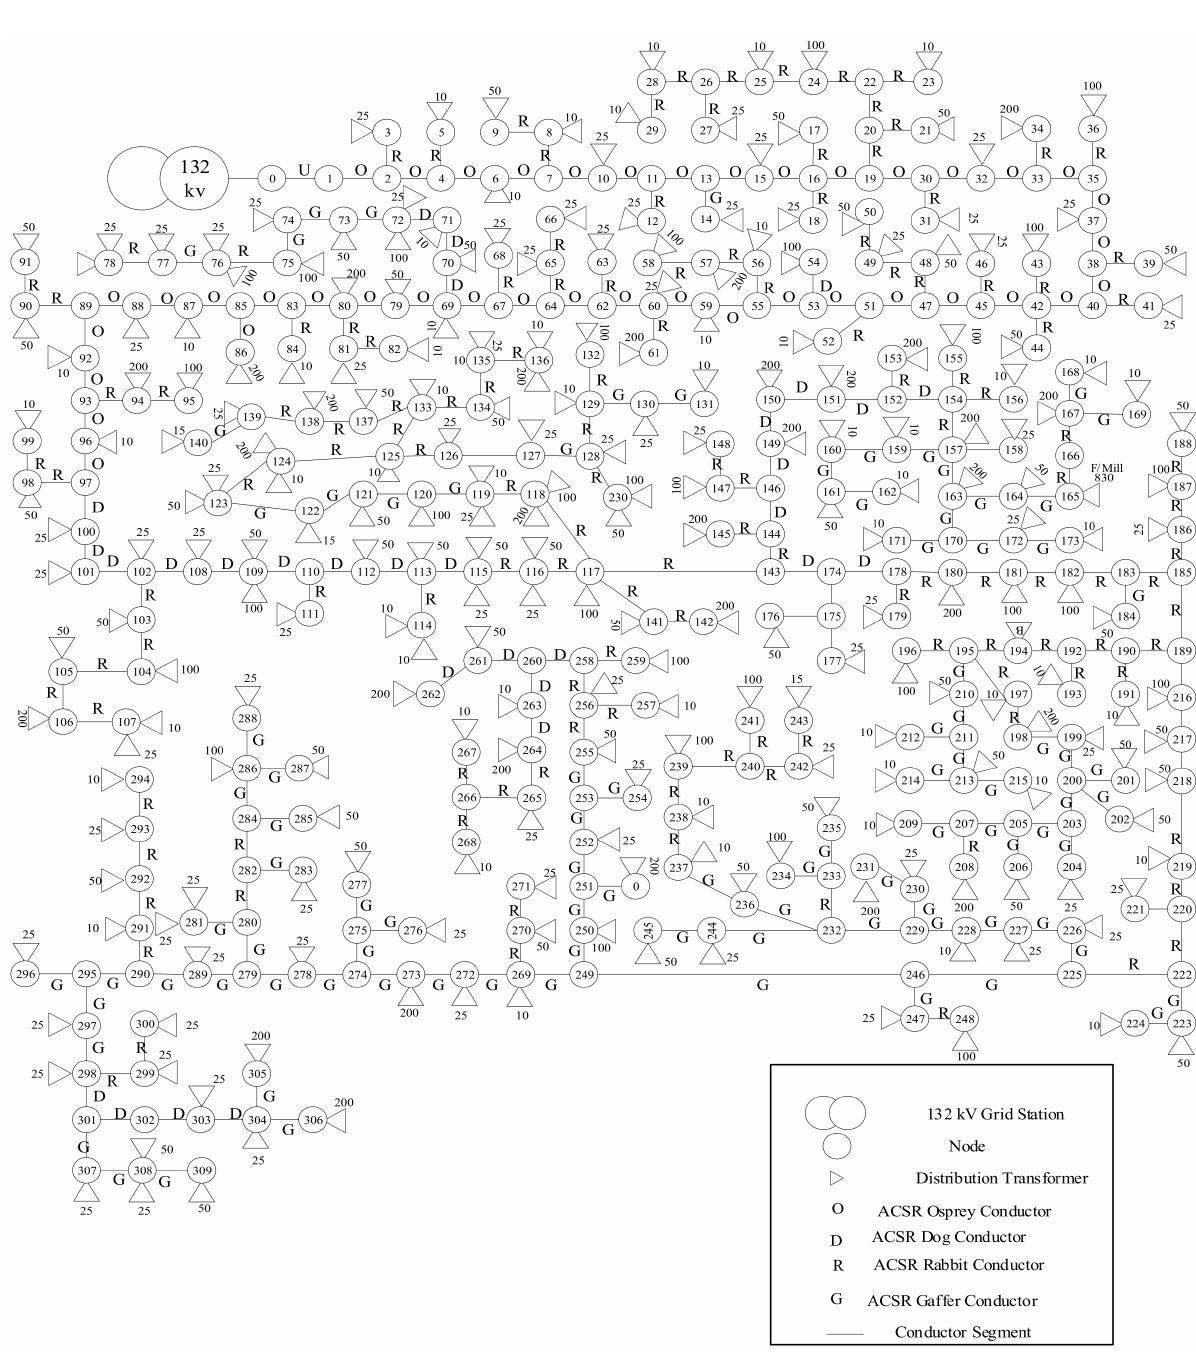
Figure 3. One-line diagram of actual feeder used for case study. The SPSO algorithm proceeds through all possible iterations. SPSO parameters such as swarm = 500, number of iterations = 3000, W min = 0.4, W max = 0.9 are the inertia weights. SPSO simulation is performed using MATLAB R2018Ra installed on a personnel computer with Intel Core i5-4200u processor, 1.60 GHz, 4GB RAM, x64-bit based Windows platform. The results obtained through MATLAB are also verified through